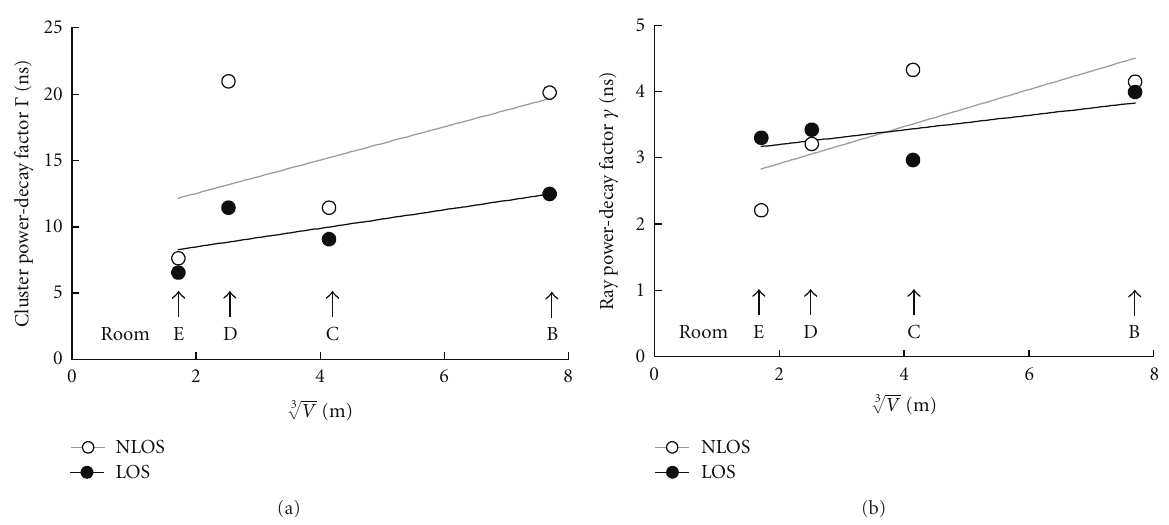
Figure 9: Power decay factors against V 1 / 3 for (a) the clusters and (b) the rays. The solid lines are the linear fitting.